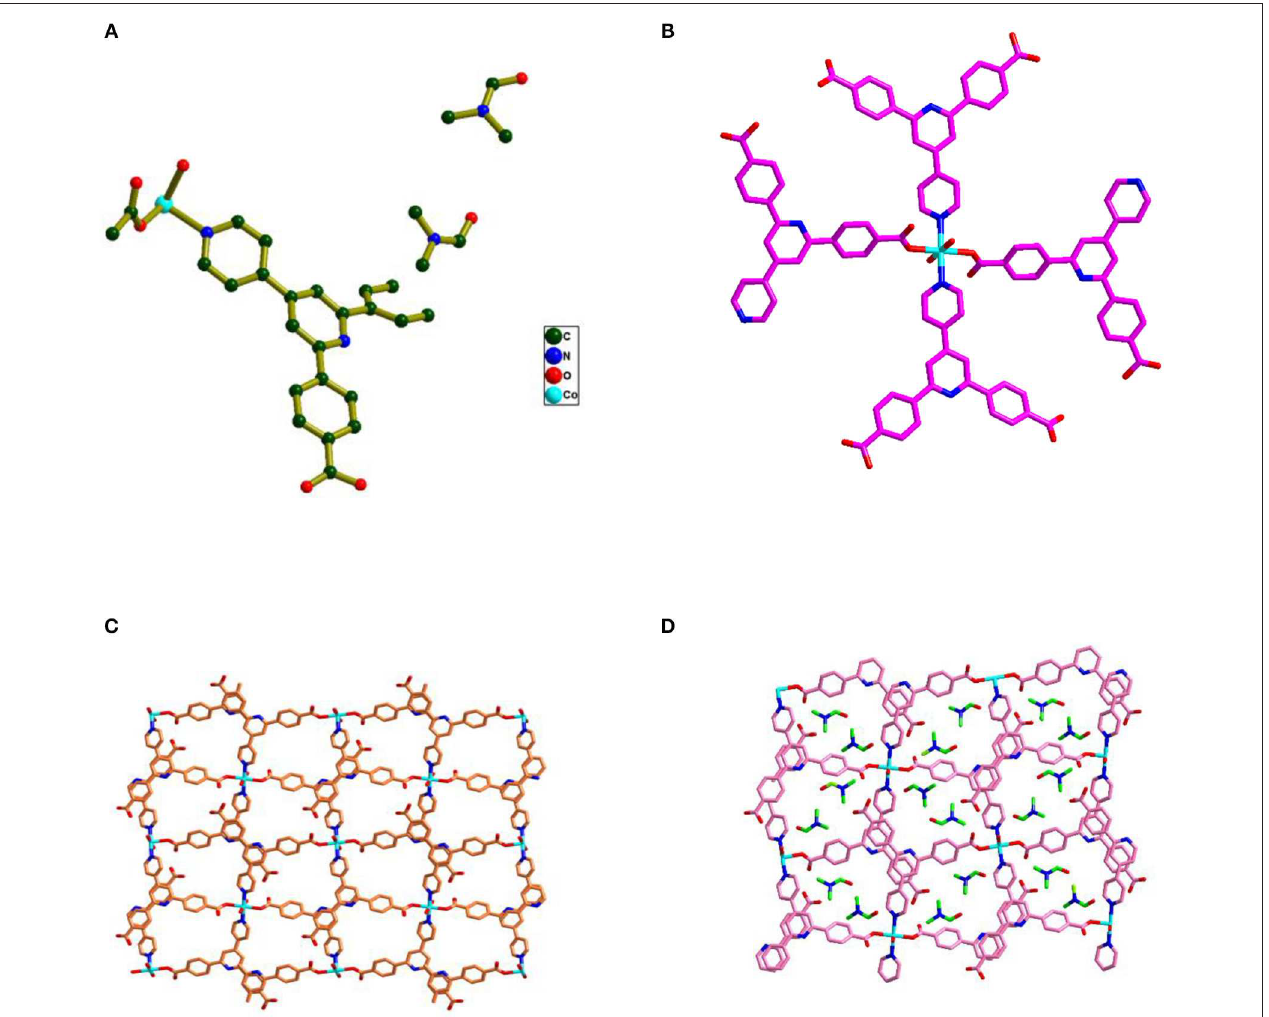
FIGURE 1 | (A) Asymmetric unit found in the crystal structure of compound 1 along with the two DMF and one water solvent molecules; hydrogen atoms are omitted for clarity. (B) Coordination environment surrounding the Co(II) metal ion. (C) 2D representation of compound 1 formed by the connectivity of the metal and Hbpydb 1 − ligand. (D) The overall structure of compound 1 including solvent DMF molecules.